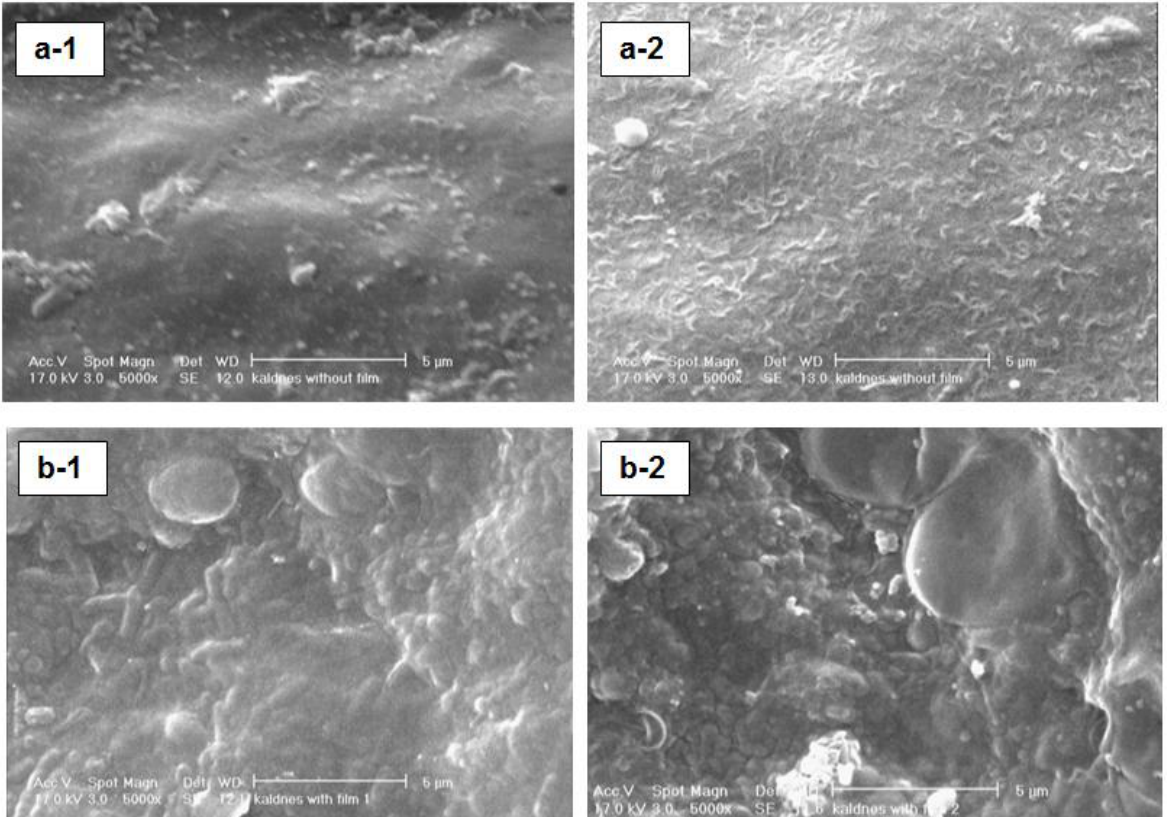
Figure 3. Scanning electron microscopy (SEM ) images of the (a-1) upper and (a-2) lower surface of the carrier without bio-film, (b-1) the carrier with bio-film and (2-b) the surface morphology of the bio-film after ammonium and chemical oxygen demand (COD ) removal in saline wastewater taken at 5000 X